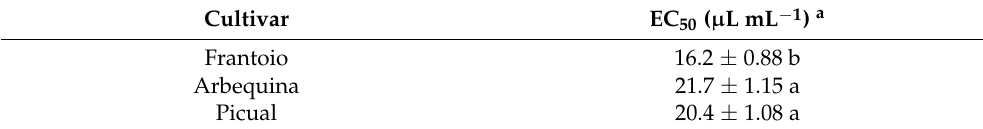
Table 1. Effective concentrations of olive stem extract (OSE) from cvs. Frantoio, Arbequina, and